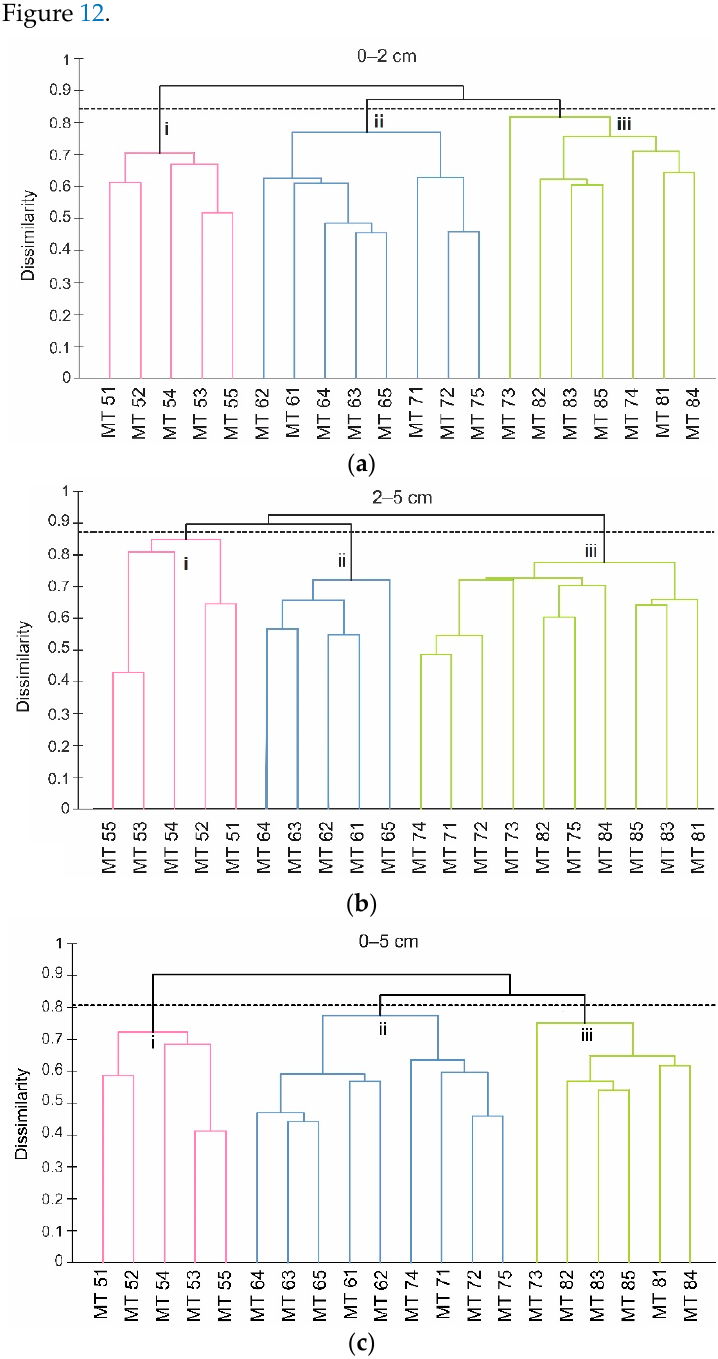
Figure 12. Dendrograms based on foraminiferal assemblages. ( a ) Surface layer. ( b ) Subsurface layer. ( c ) Integrated layer. Groups: (i) upper slope, (ii) middle slope, and (iii) lower slope. The main indicator species ( p < 0.05; and IndVal > 0.6) of dendrogram from the sur- face layer are available in Supplementary Table S4 (Supplementary Materials).